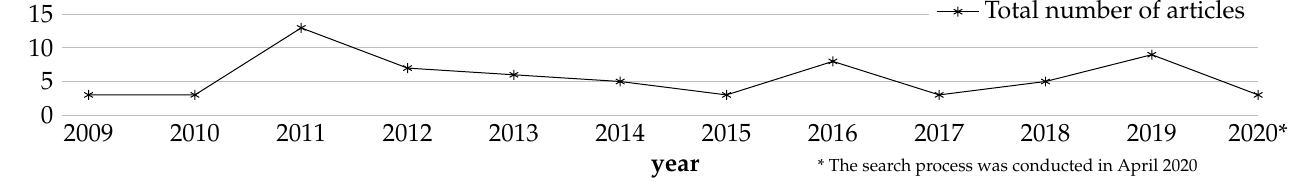
Figure 4. Total number of articles over